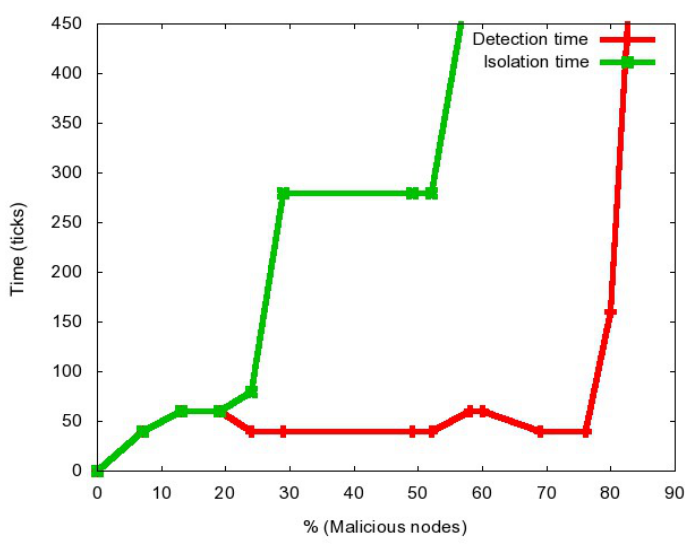
Figure 4. Detection and Isolation